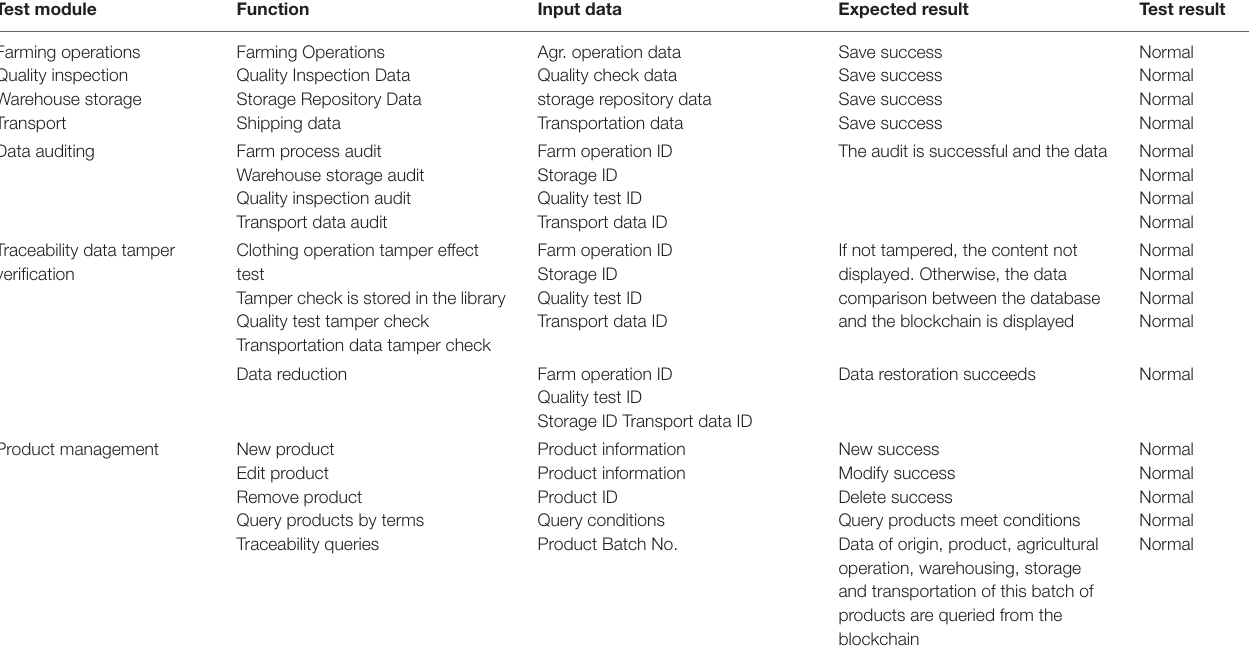
TABLE 2 | Test results of each module of the system. Test